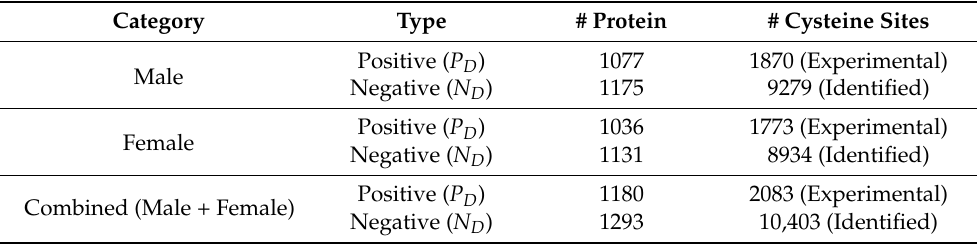
Table 5. Dataset details of positive and negative sites for all three benchmark data; Male, Female, and